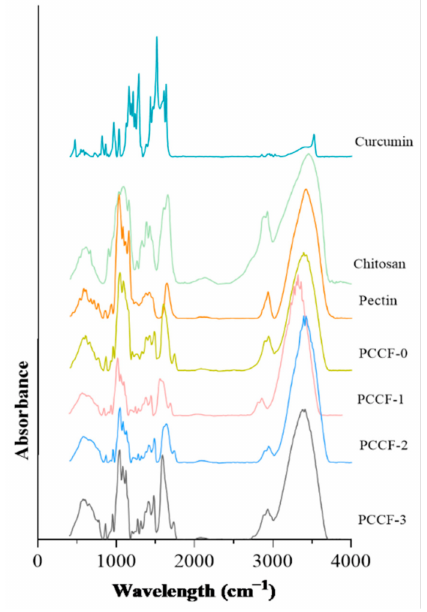
Figure 4. The Fourier transform infrared (FT-IR) spectrum of PCCF.